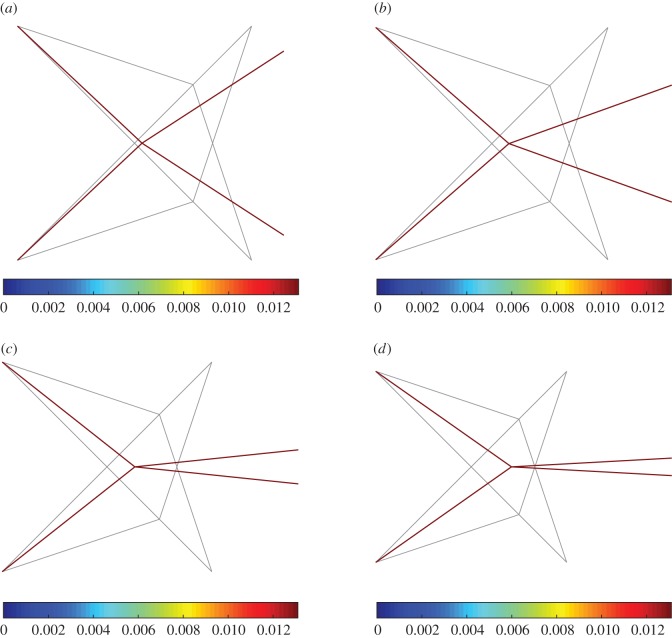
King post pantographic unit: deformation as λ increases for a=1 (the colour bar represents the global strain energy, the reference position is indicated in grey). (a) λ=0.25, (b) λ=0.5, (c) λ=0.75 and (d) λ=1.